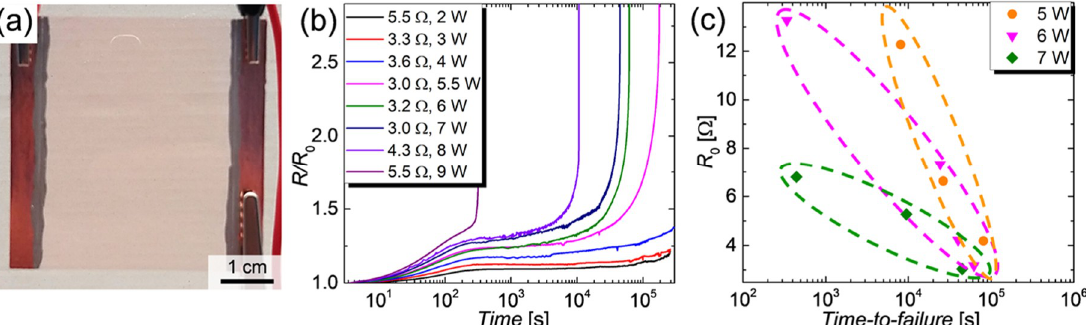
Figure 6. ( a ) Photo of a CuNW film spray-deposited to a glass substrate and electrically contacted on each side by copper tape and conductive silver ink; ( b ) Normalized resistance R / R 0 as a function of time for CuNW heaters that show resistances in a range of 3.0 Ω to 5.5 Ω and were subjected to an electrical input power ranging from 2 W to 9 W; ( c ) R 0 as a function of the time-to-failure for CuNW heaters that are subjected to powers of 5 W, 6 W and 7 W, where the ellipses indicate the regions of time-to-failure for same power